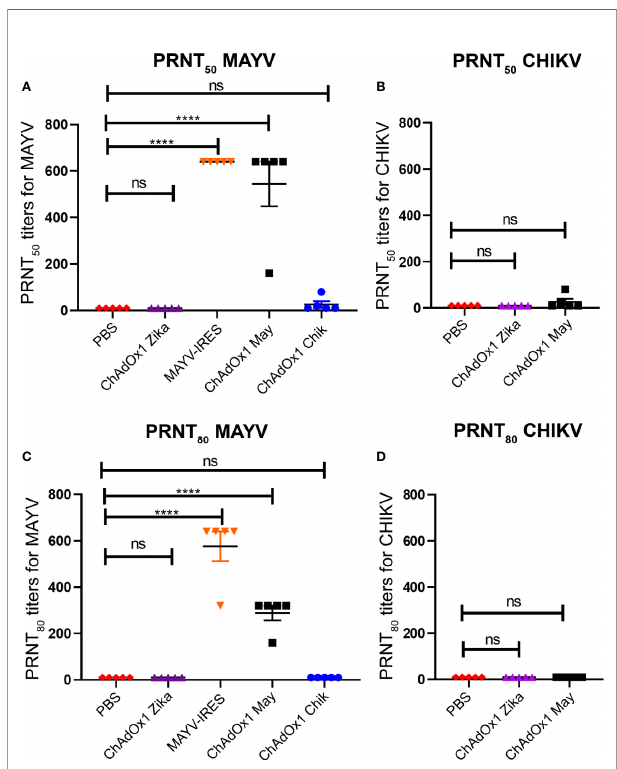
FIGURE 6 | ChAdOx1 May induces high levels of neutralizing antibodies against Mayaro virus (MAYV) but low levels of cross-neutralizing antibodies. Reciprocal neutralizing antibody titers in PRNT 50 (A) and PRNT 80 (C) against MAYV. Reciprocal neutralizing antibody titers in PRNT 50 (B) and PRNT 80 (D) against CHIKV, done in a separate experiment. The limit of detection (LOD) is 20 (1:20 dilution), data points recorded as 10 had neutralization values < LOD. Dots represent titers for each animal, bars represent mean and SEM, one-way ANOVA with Dunnett ’ s, ****p < 0.0001. ns, not signi fi